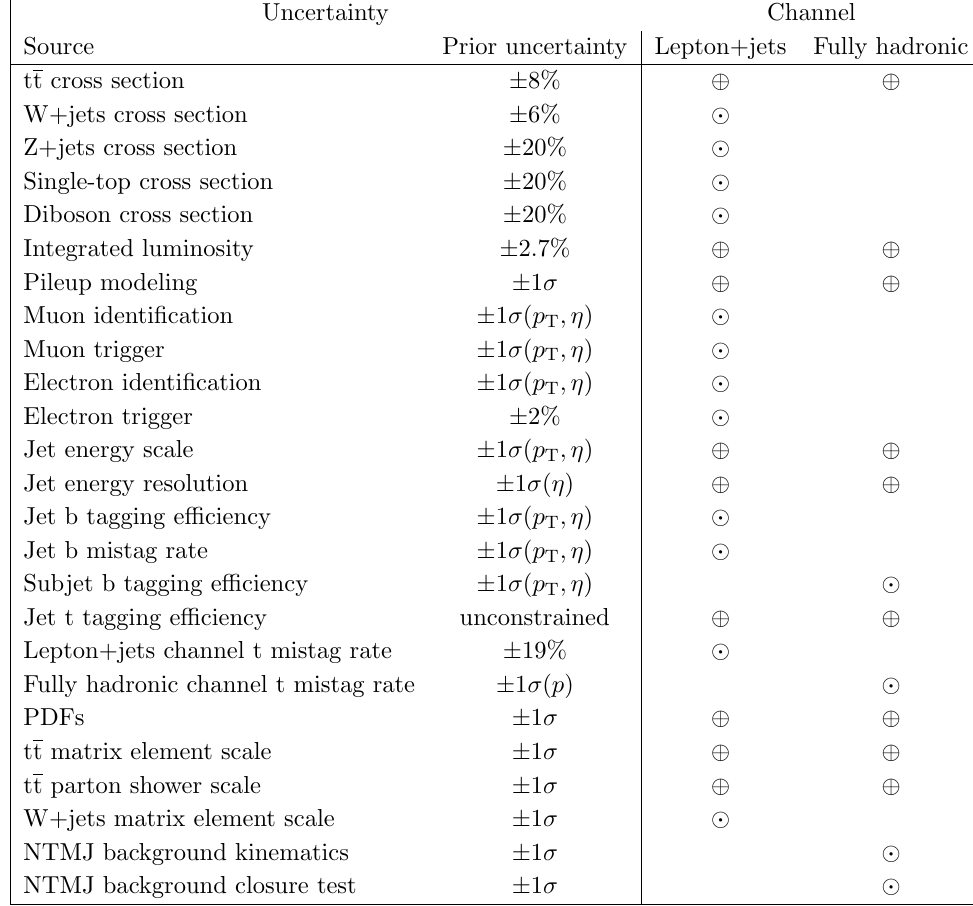
Table 2 . Sources of uncertainty and the channels they a(cid:11)ect. Uncorrelated uncertainties applied to a given channel are labeled with a (cid:12) . Uncertainties that are correlated between channels are labeled with a (cid:8) . In this table, (cid:27) denotes the uncertainty in the given prior value in the likelihood (cid:12)t. best (cid:12)t values obtained from this maximum likelihood evaluation are used to correct the distributions of background and signal